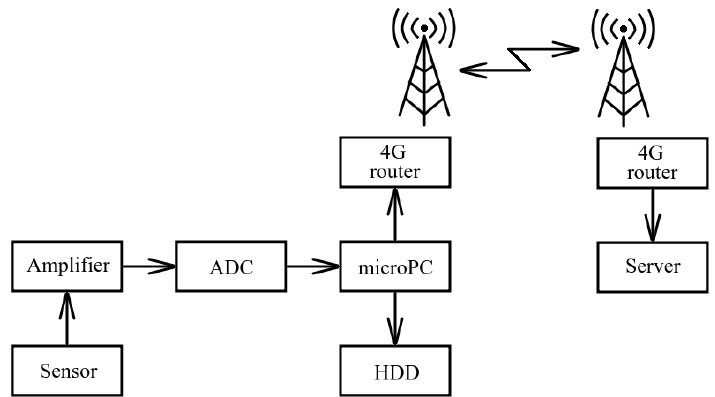
Figure 6. Block scheme of the spaced system for acoustic data